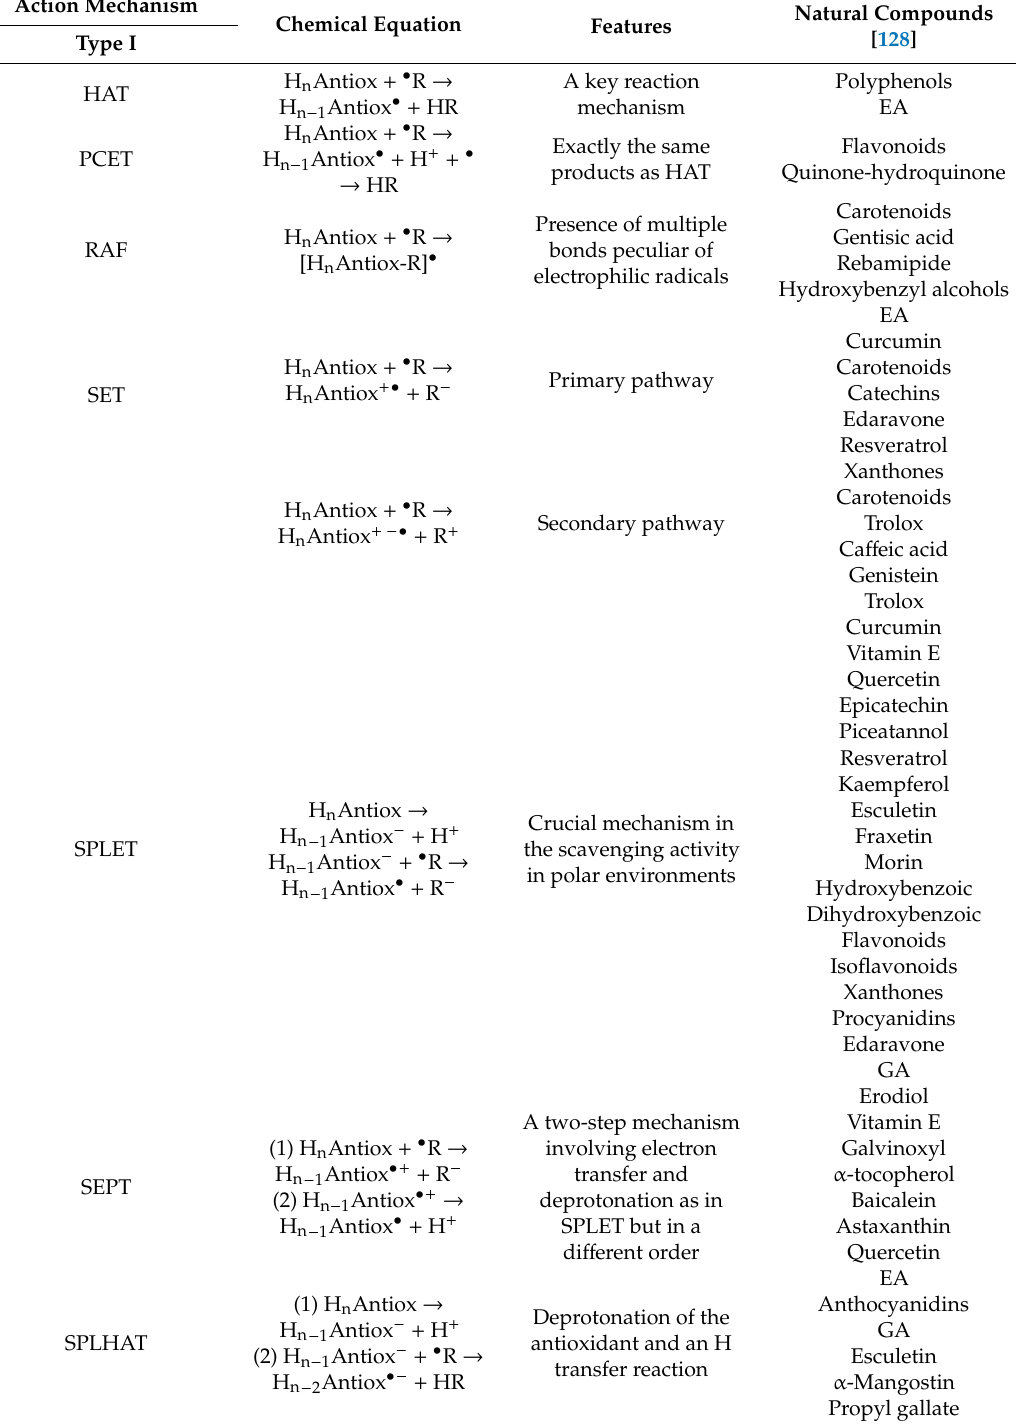
Table 9. Possible action mechanisms of the Type I antioxidants and related